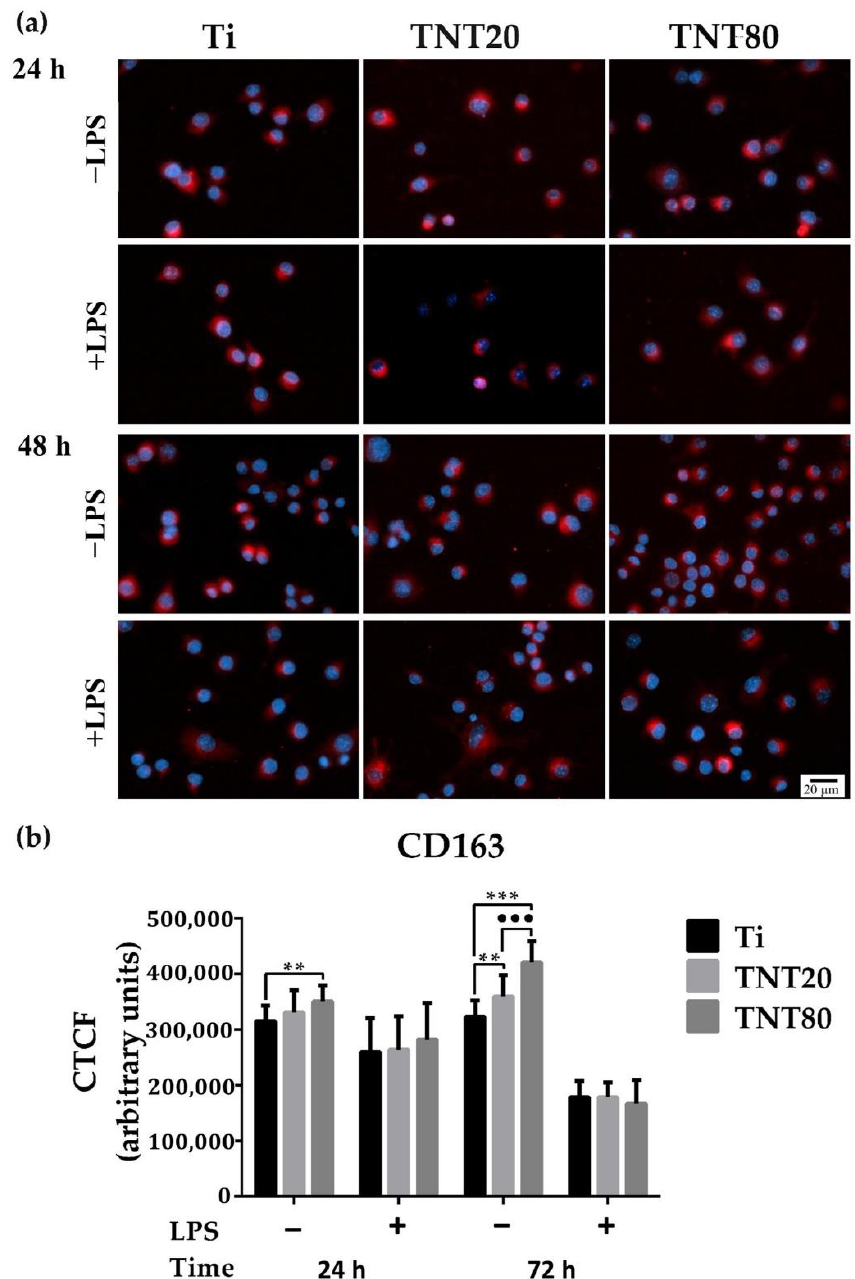
Figure 5. CD163 expression in RAW 264.7 cells maintained in contact with the tested surfaces for 24 h and 48 h, under standard ( − LPS) and pro-inflammatory (+LPS) culture conditions. ( a ) Immunofluorescence staining of CD163 (red fluorescence: anti-inflammatory biomarker CD163; blue fluorescence: cell nuclei). All images were captured at the same magnification (scale bare represents 20 µm). ( b ) Corrected total cellular florescence (CTCF) of individual cells quantified by using the Image J software. An increase in the expression of M2 macrophage marker, CD163, was noticed on the nanostructured surfaces, mainly TNT80, when compared to the Ti sample. Results are represented as means ± SD ( n = 30, ** p < 0.01, *** p < 0.001 vs. Ti, ••• p < 0.001 vs. TNT20).